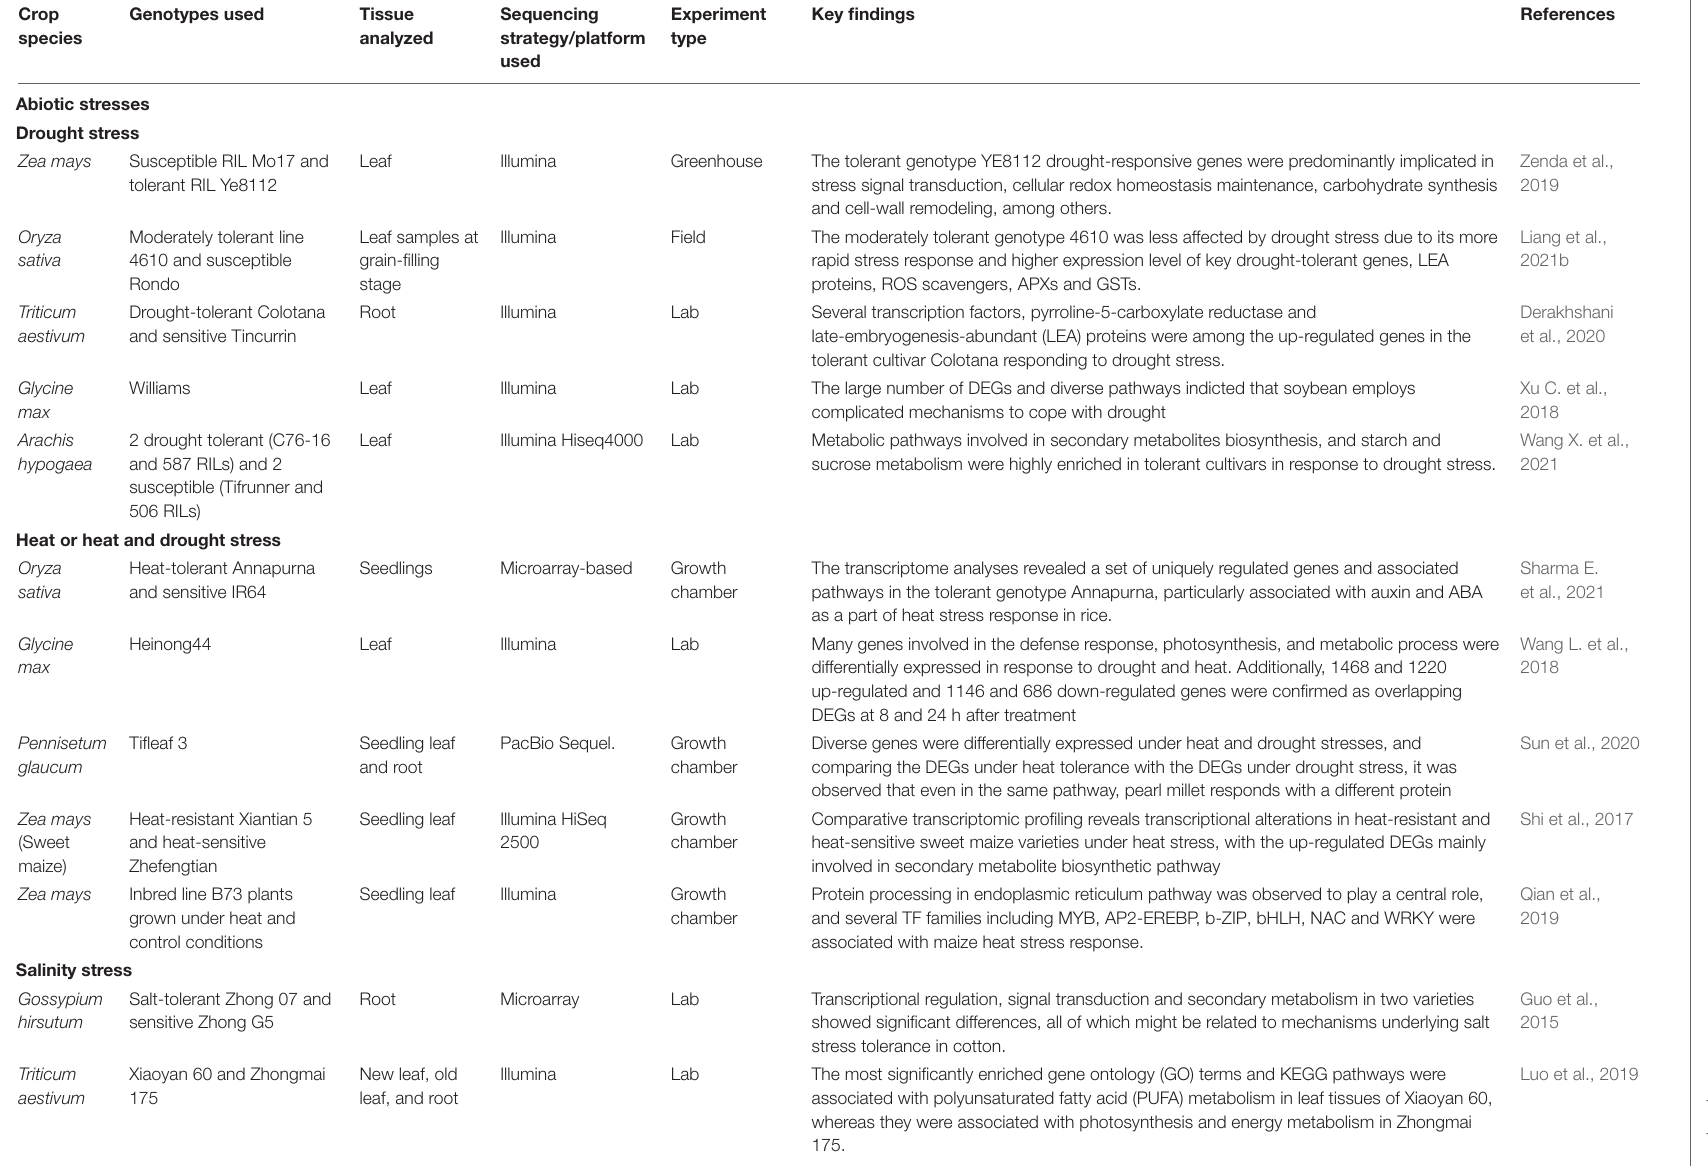
TABLE 3 | Selected examples of transcriptomic studies for abiotic and biotic stress tolerance in different crop